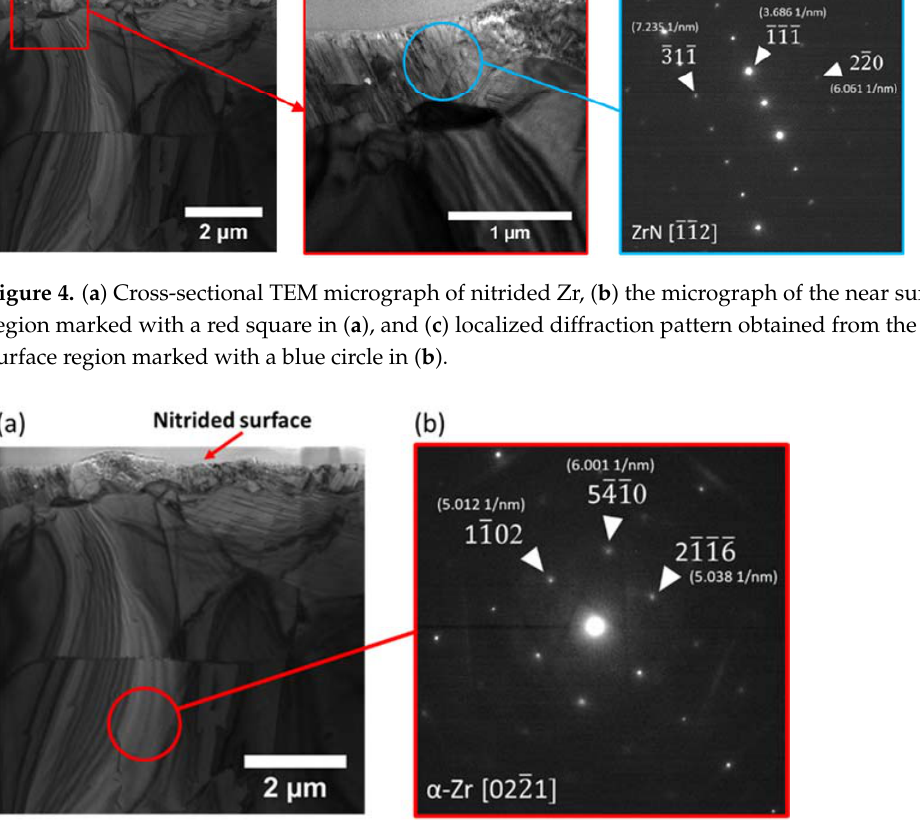
Figure 5. ( a ) Cross-sectional TEM micrograph of nitrided Zr and ( b ) localized diffraction pattern obtained from a region marked with a red circle in ( a ).